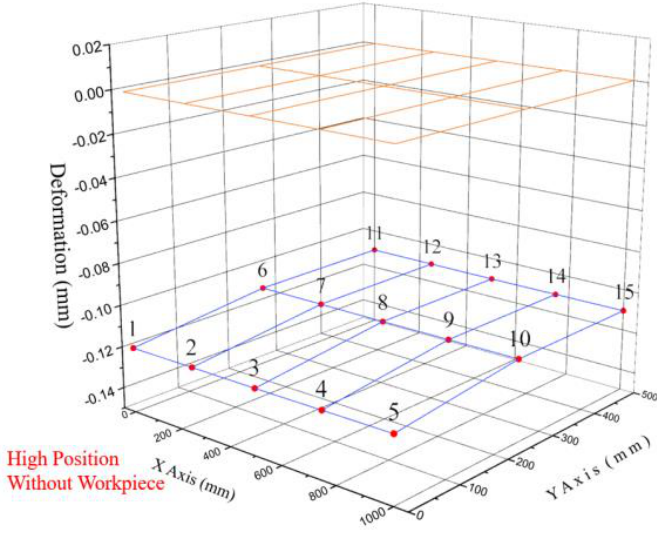
Figure 12. Schematic diagram of no load at the high point of the spindle.